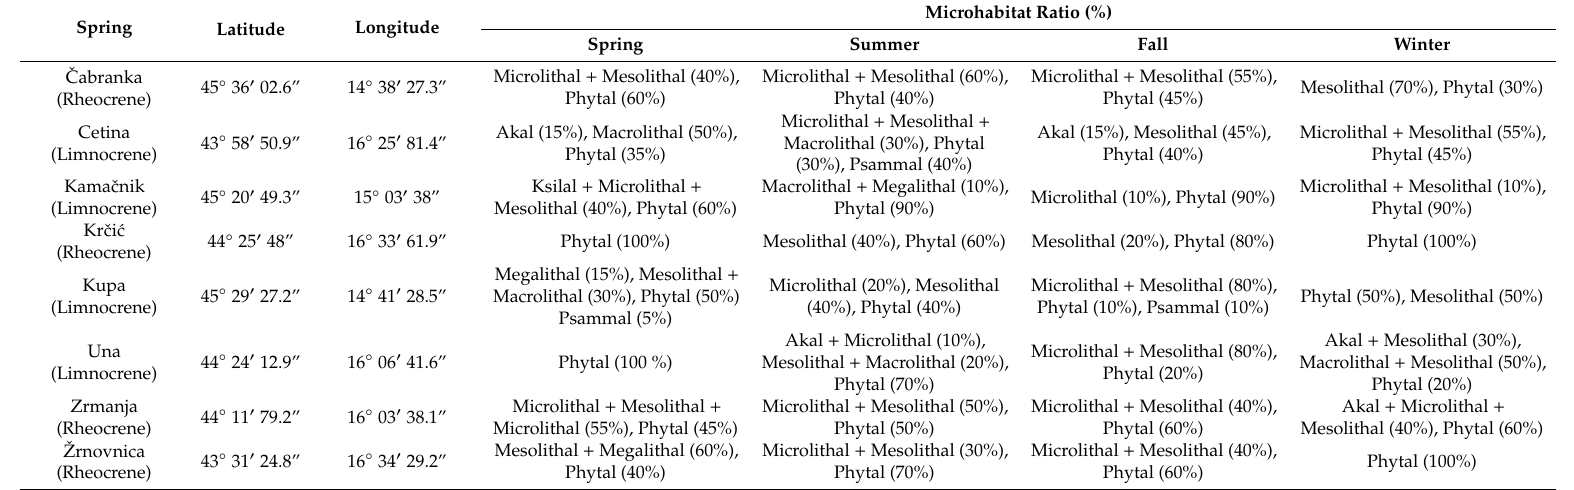
Table A2. Seasonal microhabitat ratios in the studied limnocrenes and rheocrenes.